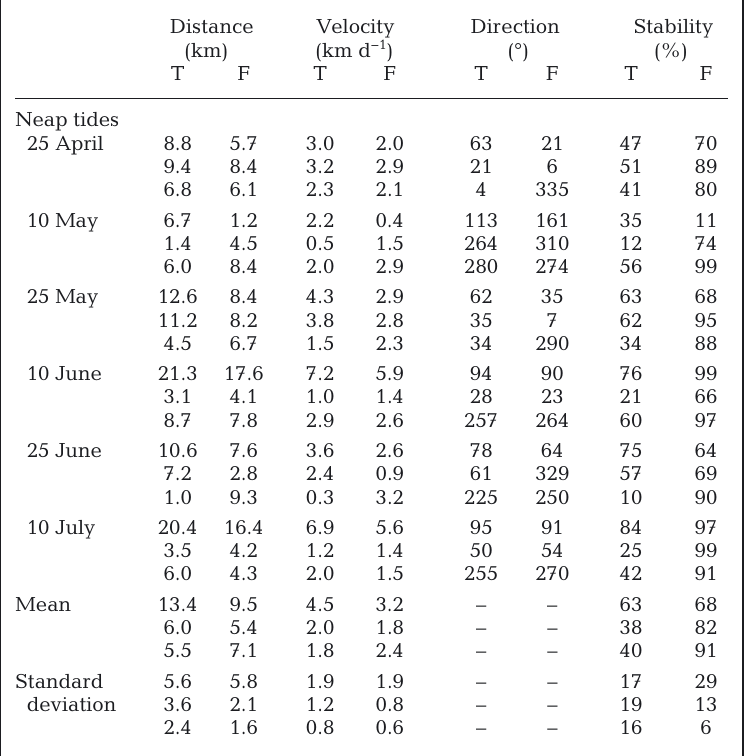
Table 2. Residual distances, velocities, directions and stability coming from progressive vector diagrams during 6 neap tide periods. T: total currents and F: filtered currents. Each of these periods spans 3 d starting on the date shown. Each cell includes surface (upper), midwater (center) and bottom (lower) currents. –: not